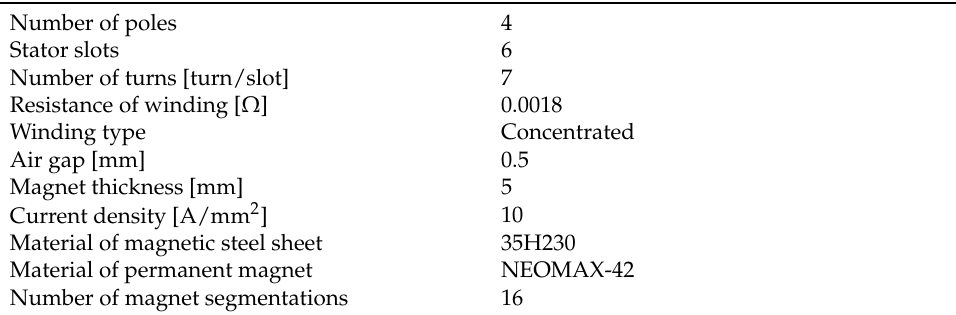
Figure 3. Dimensions of designed PMSM. Table 2. Specifications of